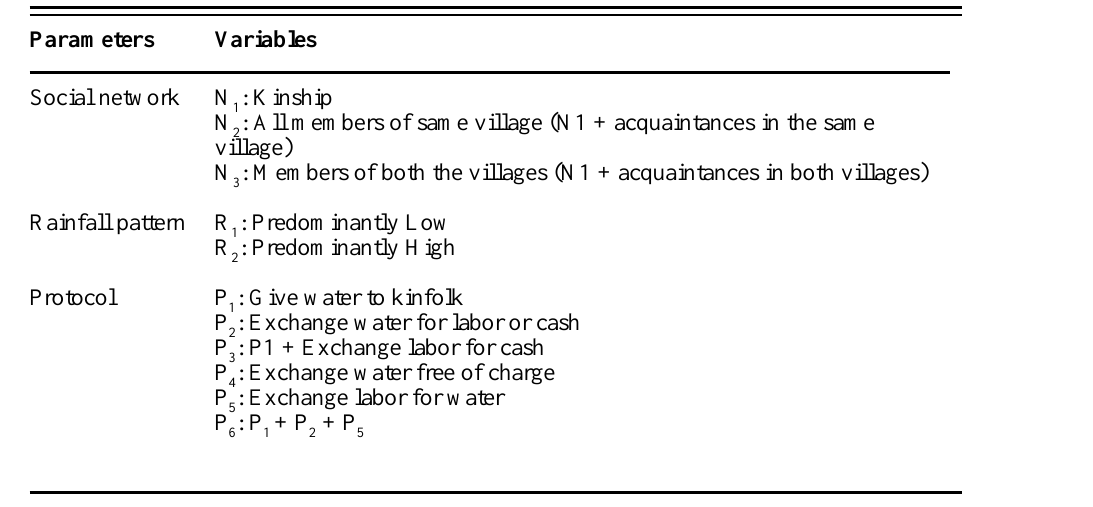
Table 2. Possible factors to be simulated with the Limbukha model